Question: What kind of plot is shown here?
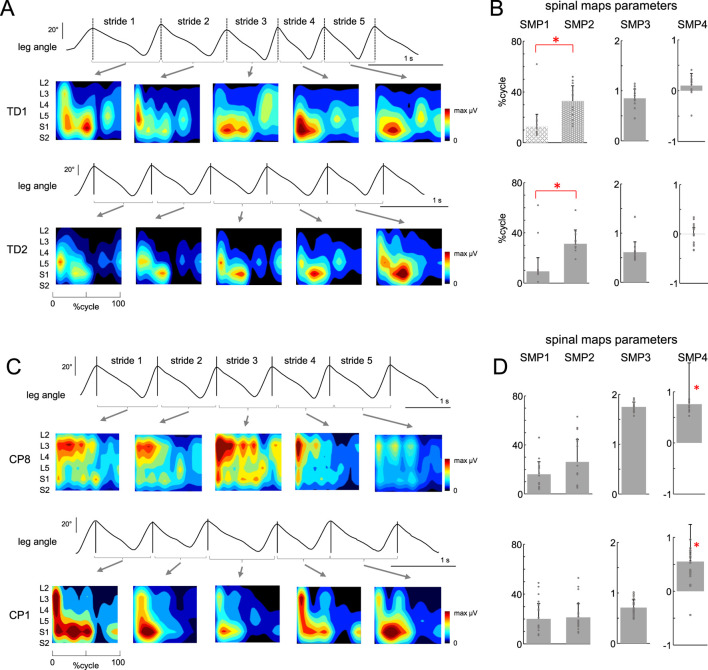
Answer: line